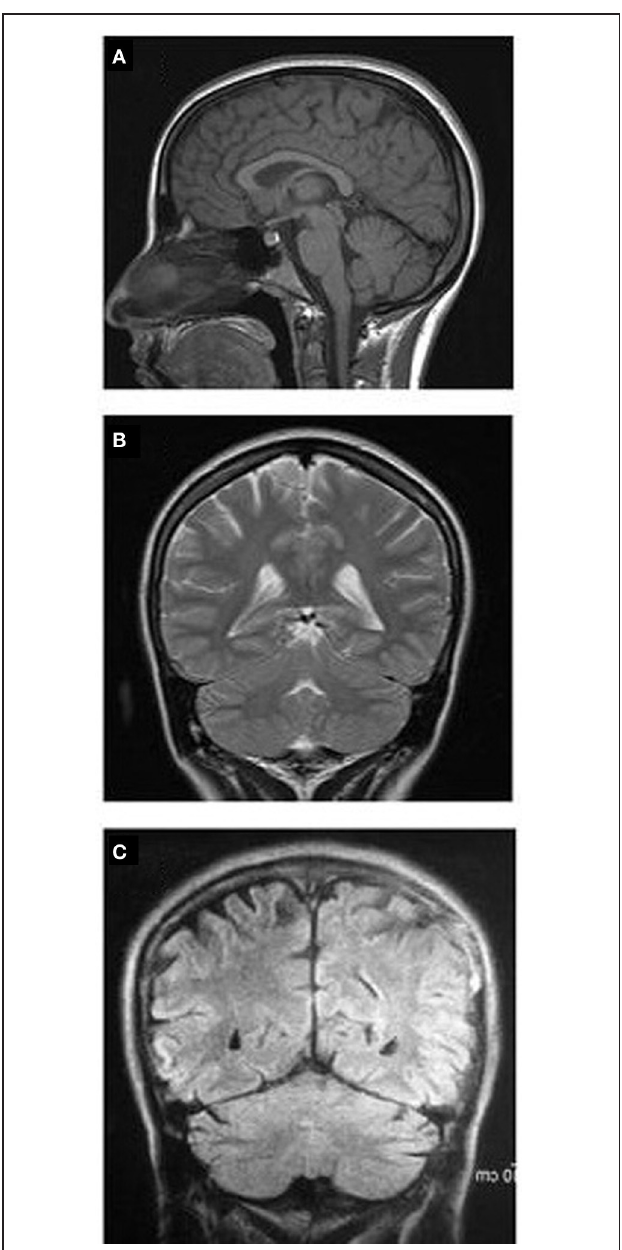
FIGURE 1 | MRI images showing sagittal (A) and coronal (B) sections of case 1 with facultative QL; (C) coronal MRI of case 2 with a paralyzed leg. Notice the entirely normal brain structures in both